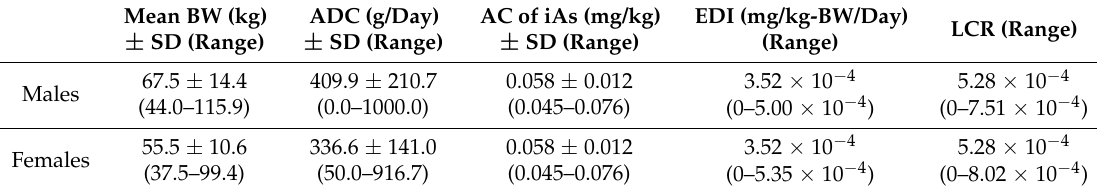
Table 3. EDI and LCR